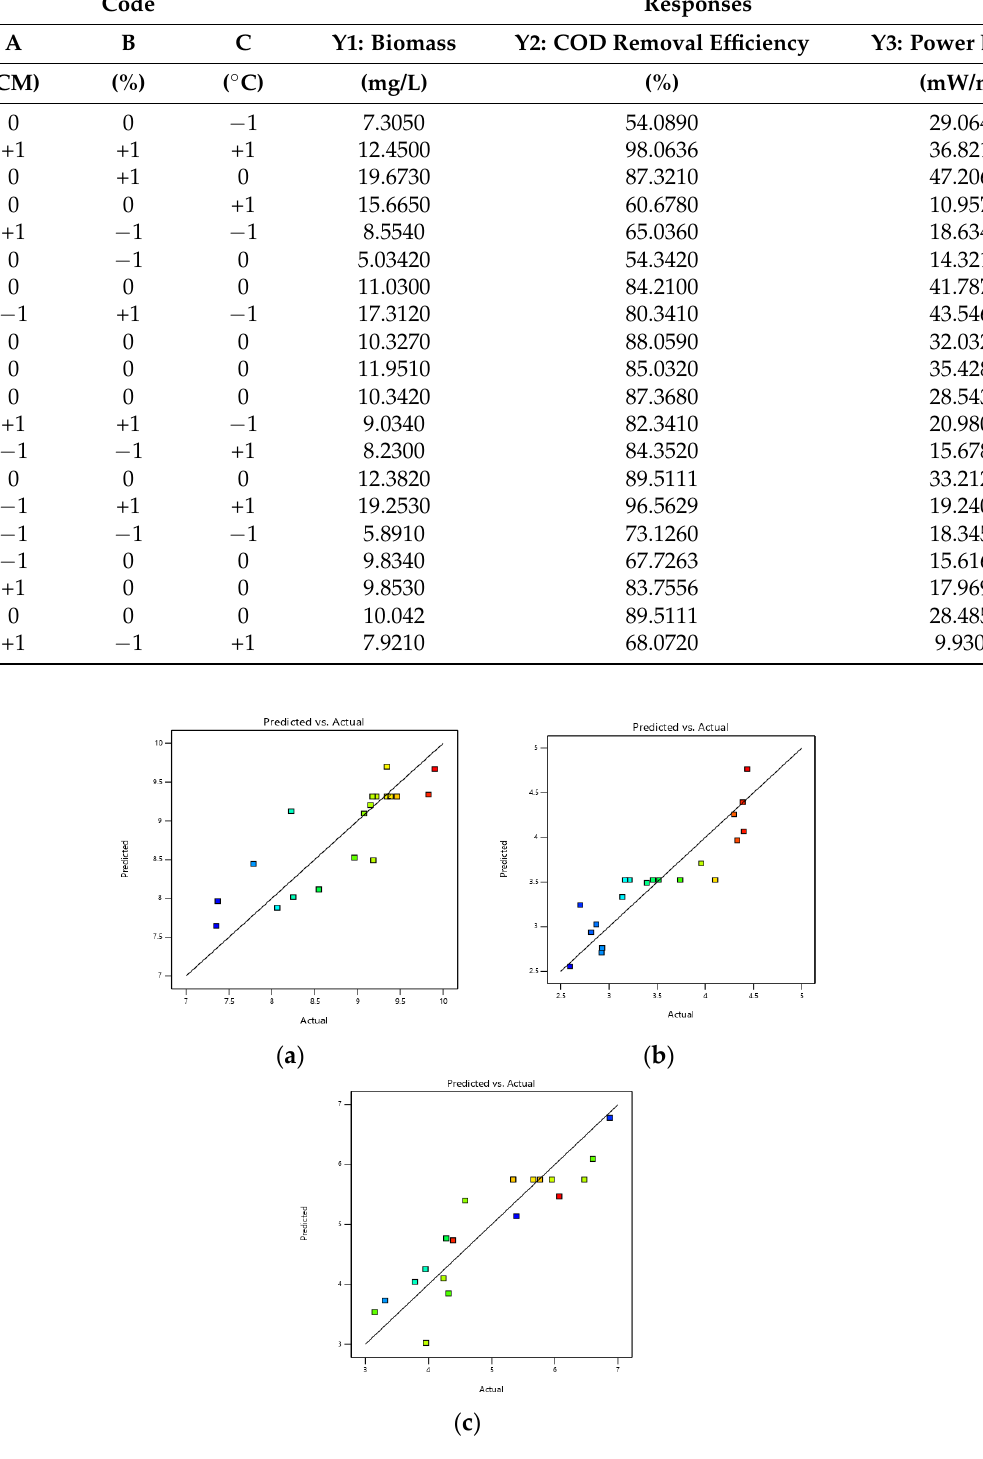
Figure 1. Comparison of predicted values and experimental values for ( a ) biomass, ( b ) COD removal efficiency, and ( c ) power density generation.